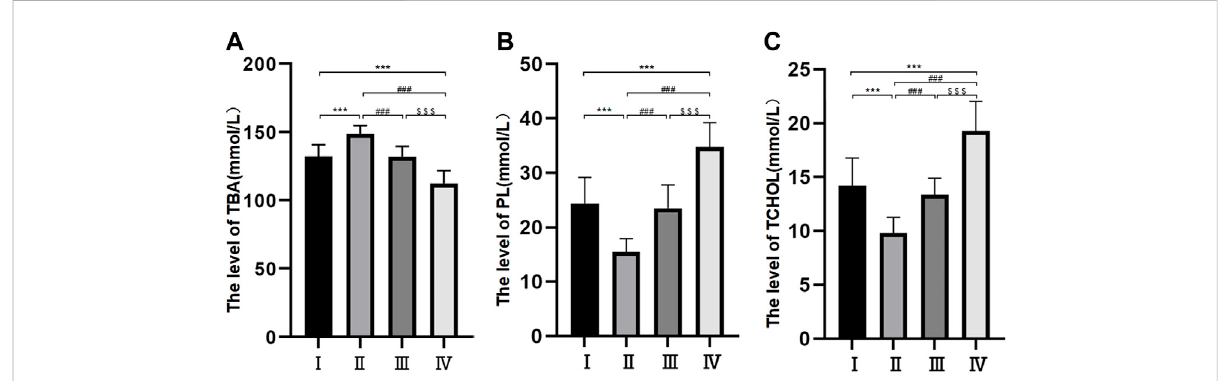
FIGURE 1 BilecompositionhistogramofTBA,PLandTCHOL.* p < 0.05,** p < 0.01,*** p < 0.001versusgroupI;# p < 0.05,## p < 0.01,### p < 0.001versusgroup